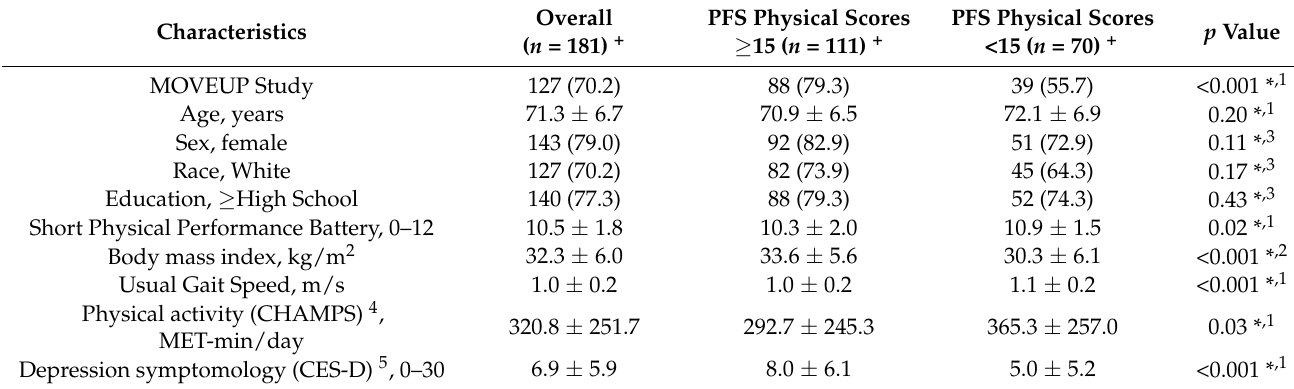
Table 1. Characteristics of overall sample and stratified by Pittsburgh Fatigability Scale (PFS) perceived physical fatigabil- ity status.